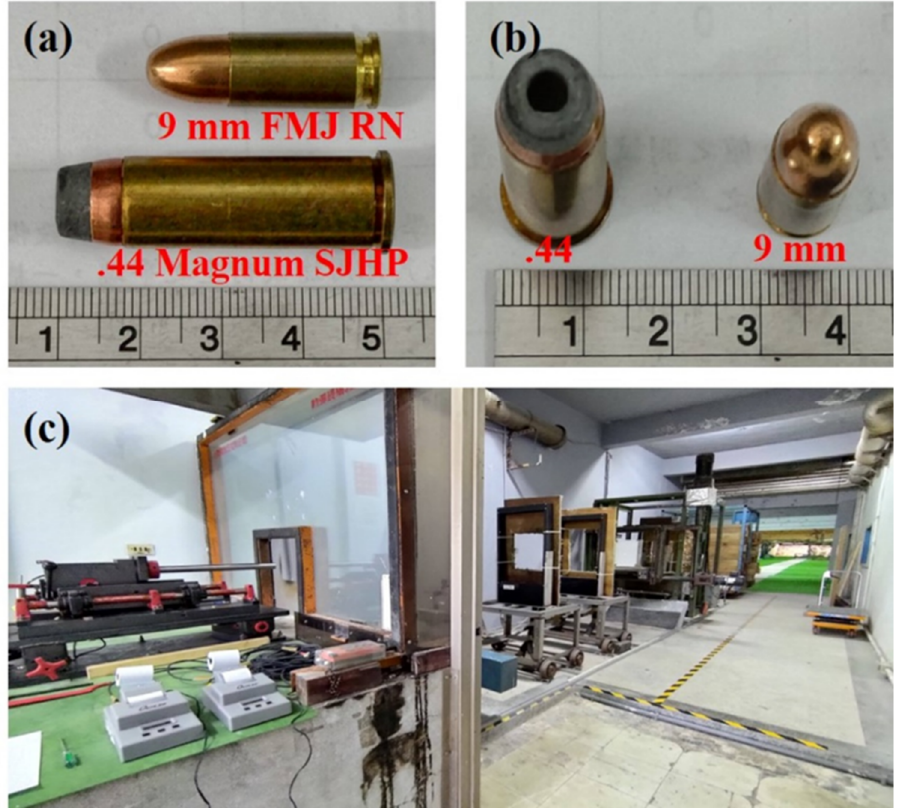
Figure 1. ( a ) Side view of 9 mm FMJ RN and .44 Magnum SJHP bullets; ( b ) Top view of 9 mm FMJ RN and .44 Magnum SJHP bullets; ( c ) Schematic set-up of the ballistic test setup.